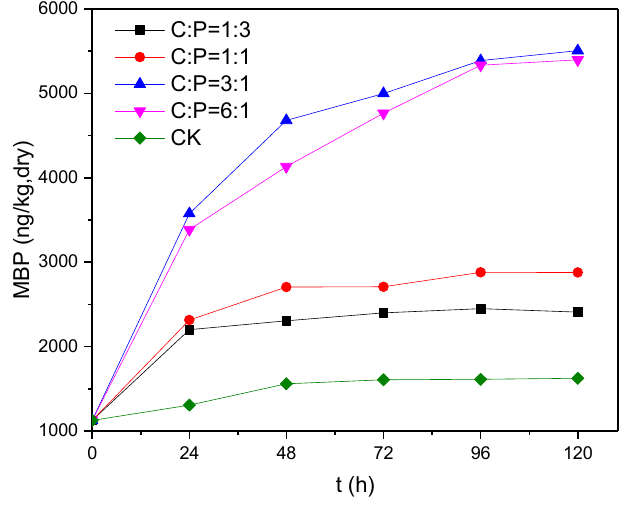
Figure 5. Changes in MBP concentration over time at different C/P ratios.